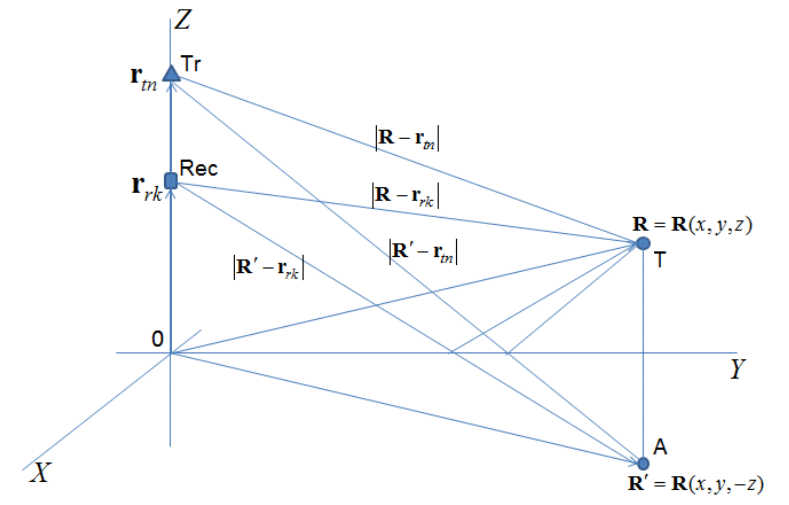
Fig. 2. Ray paths for a pair of phase centers of transmitting and receiving subarrays of MIMO radar, target (T) and antipode